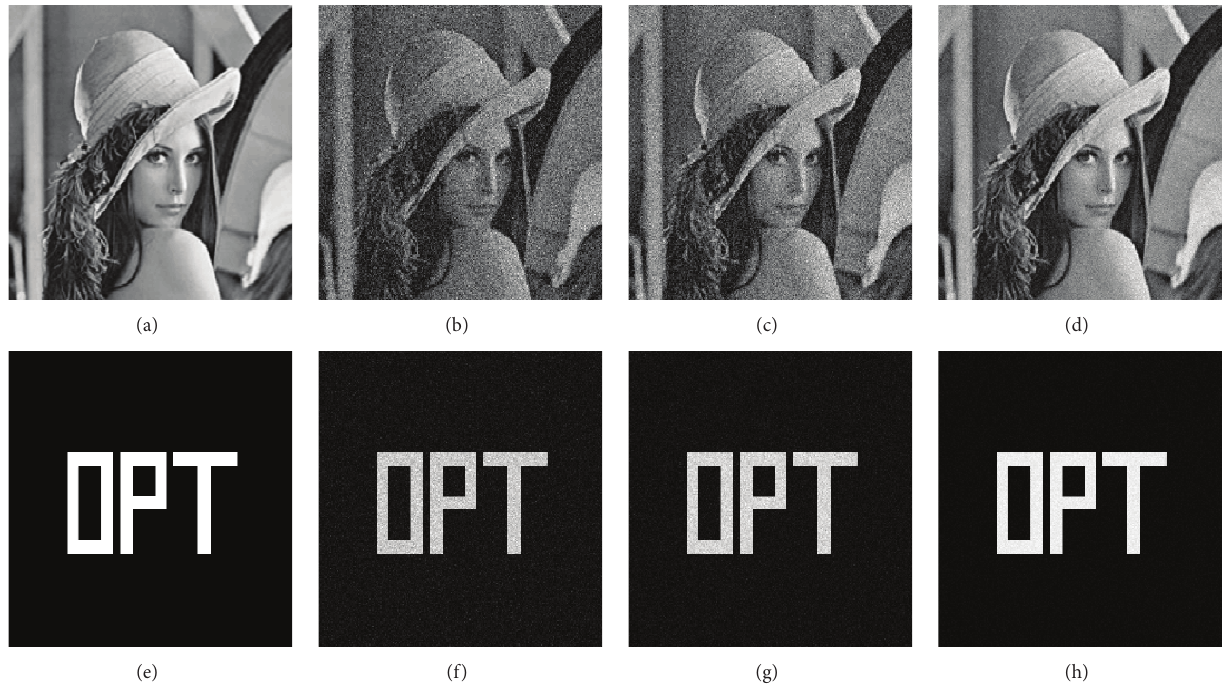
Figure 11: (a) Input image Lena; (b–d) recovered grayscale images corresponding to salt and pepper noise (density = 0.05), Gaussian noise (variance = 0.05), and speckle noise (variance = 0.05), respectively; (e) input binary image OPT; (f–h) recovered binary images corresponding to salt and pepper noise, Gaussian noise, and speckle noise,